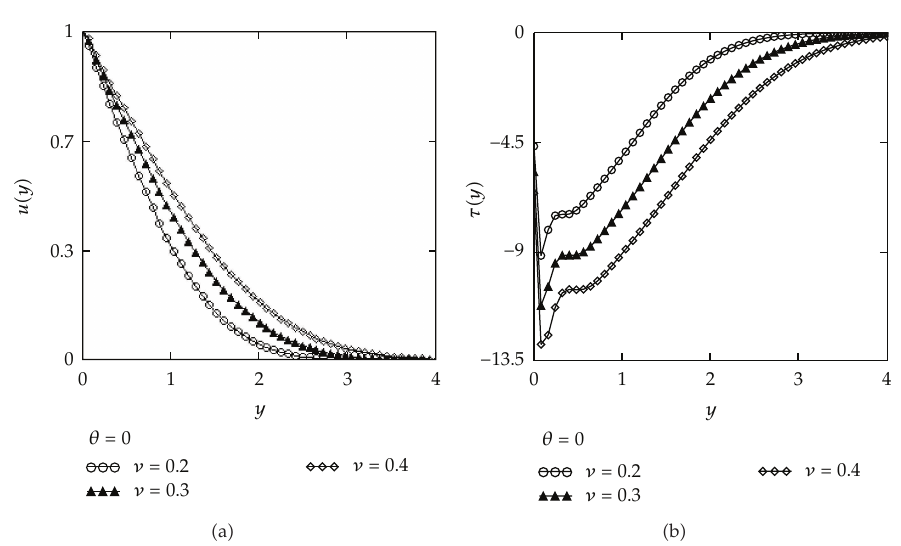
Figure 10: Profiles of the velocity field u (cid:4) y,t (cid:5) and the shear stress τ (cid:4) y,t (cid:5) for fractional Maxwell fluid given by (cid:4) 5.3 (cid:5) and (cid:4) 5.4 (cid:5) , for U (cid:9) 1, y (cid:9) 1, ρ (cid:9) 87 . 071, λ (cid:9) 1 . 5, α (cid:9) 0 . 2, θ (cid:9) 0 . 0, t (cid:9) 5s, and di ff erent values of ν .